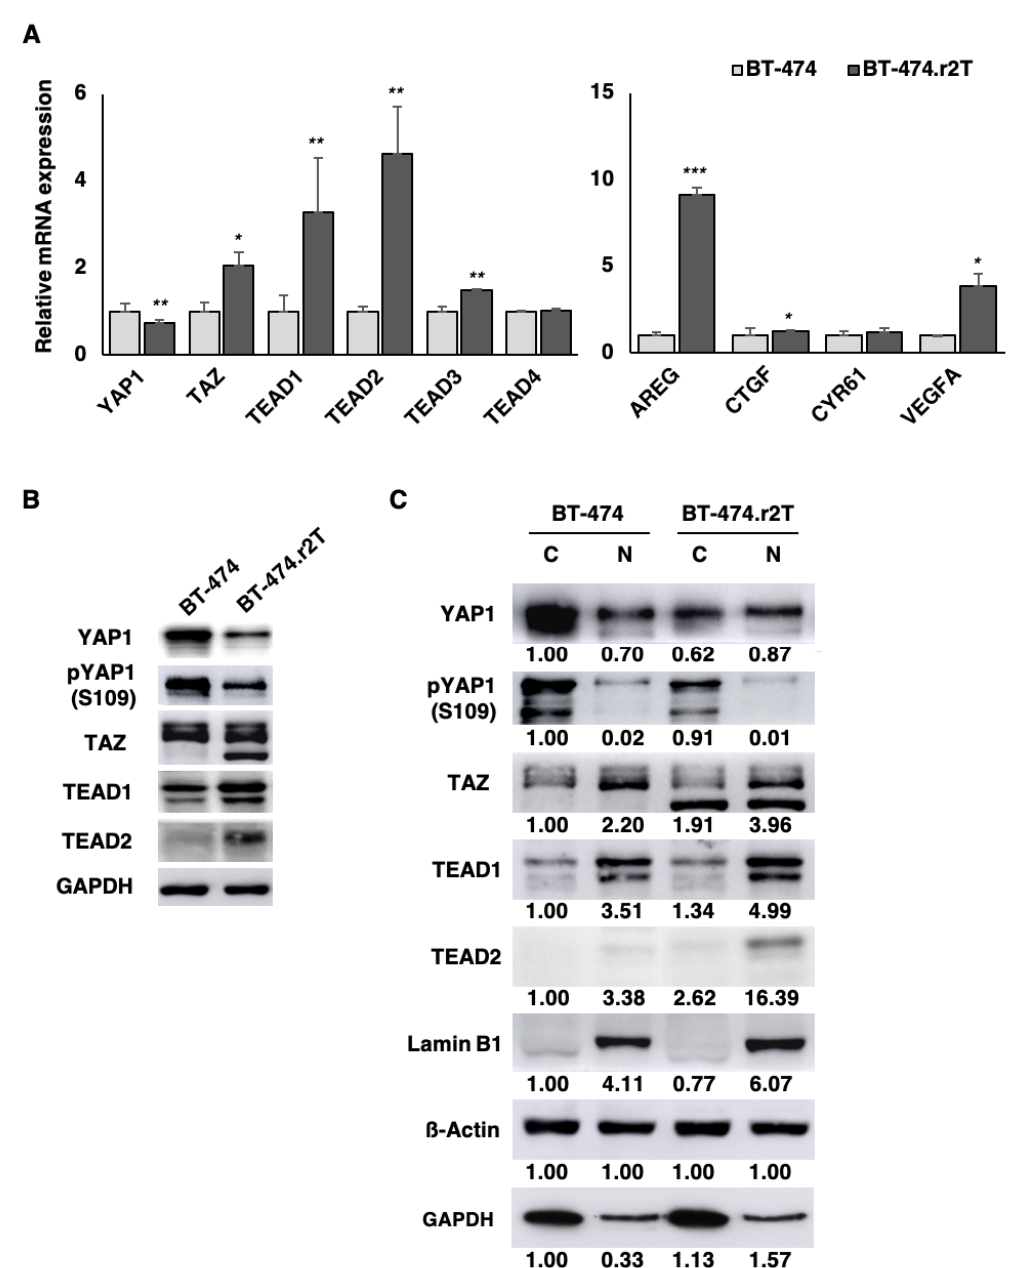
Figure 4. TEAD1 and TEAD2 are highly expressed in trastuzumab-resistant BT-474.r2T cells and, together with YAP1, are upregulated in response to acquired trastuzumab resistance. 2.5E6 cells were seeded in 6-multiwell plates, and after 96 h of treatment, whole cell protein isolation, nuclear-cytoplasm protein fractionation, or RNA isolation were performed. ( A ) qPCR analysis of relative YAP1 , TAZ , TEAD1 , TEAD2 , TEAD3 , TEAD4 , AREG , CTGF , CYR61 , and VEGFA mRNA expression following in vitro generation of trastuzumab-resistant BT-474.r2T cells (*: p < 0.05, **: p < 0.01, ***: p <